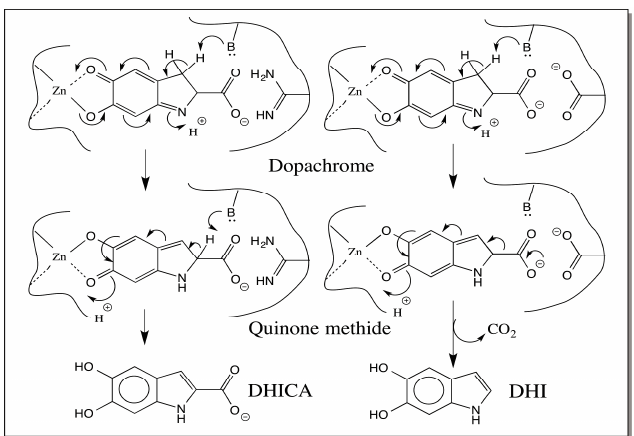
Figure 5. Possible role of active site in diverting the course of dopachrome conversion reaction. The